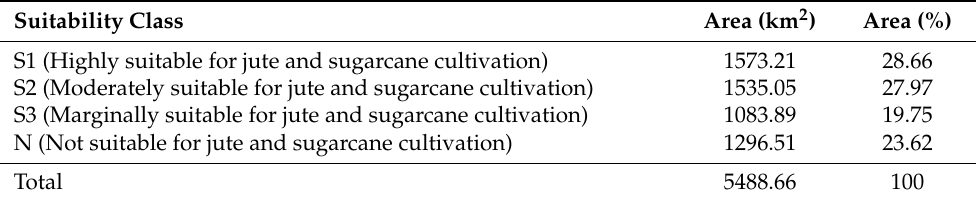
Table 6. Suitable areas for jute and sugarcane cultivation according to their suitability classes in the Sirajganj and Tangail